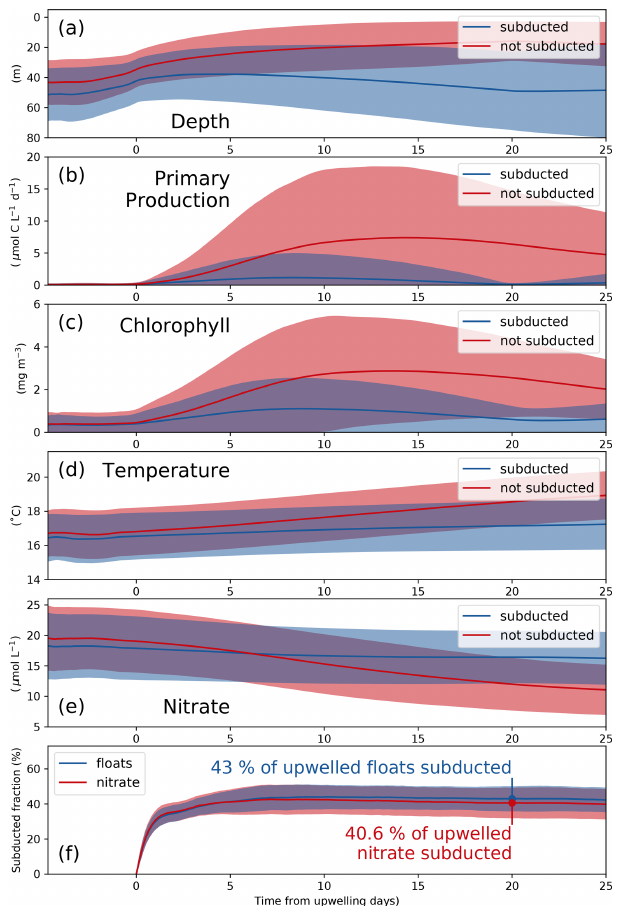
Figure 6. (a) Depth, (b) primary production, (c) chlorophyll, (d) temperature, and (e) nitrate averaged over all subducted (solid) and not-subducted (dashed) floats from 20 ensemble members. Blue and red shading indicates the range of ± 1 standard deviation based on all subducted and not-subducted floats, respectively. (f) Sub- ducted fraction of floats and nitrate. Shaded areas represent the range of ± 1 standard deviation based on 20 ensemble members. The results shown here are based on the submesoscale-permitting (1 / 45 ◦ ) simulation.